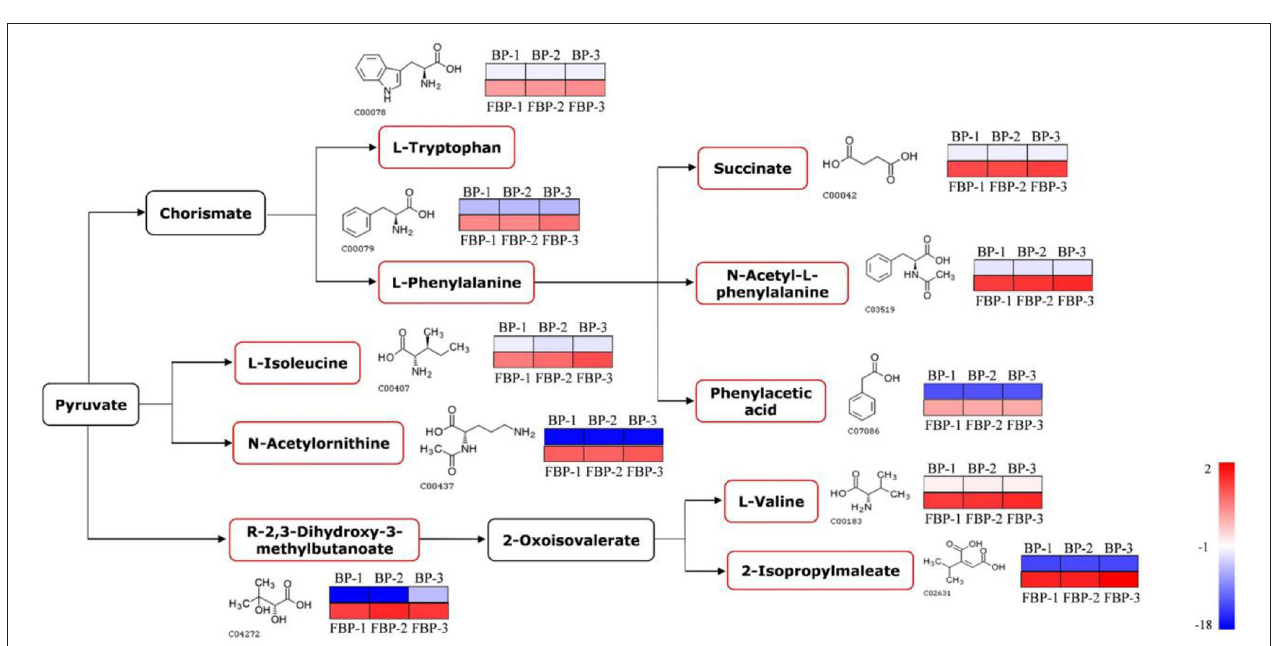
FIGURE 5 | The changed metabolic pathways due to S. cerevisiae fermentation in B. napus bee pollen based on KEGG pathway analysis. The red frame represented that the content of those highlighted metabolites was significantly increased in the fermented bee pollen compared to the unfermented bee pollen. The color bar from blue to red indicated the metabolite level from low to